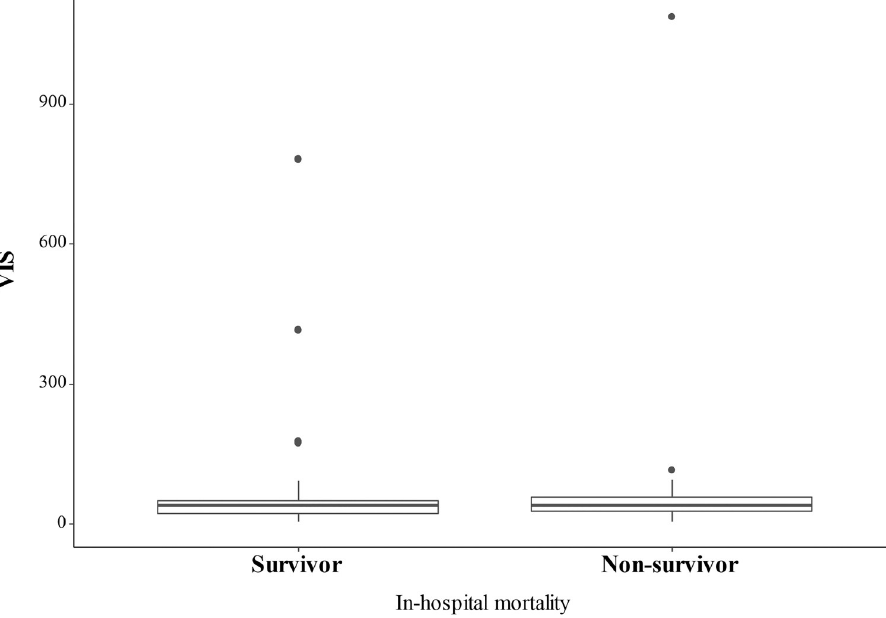
Fig 3. The peak vasoactive-inotropic scores according to the in-hospital mortality. The bold line in the middle indicates the median, and the top and bottom of the square indicate the interquartile ranges of the vasoactive-inotropic scores. VIS, vasoactive-inotropic score.